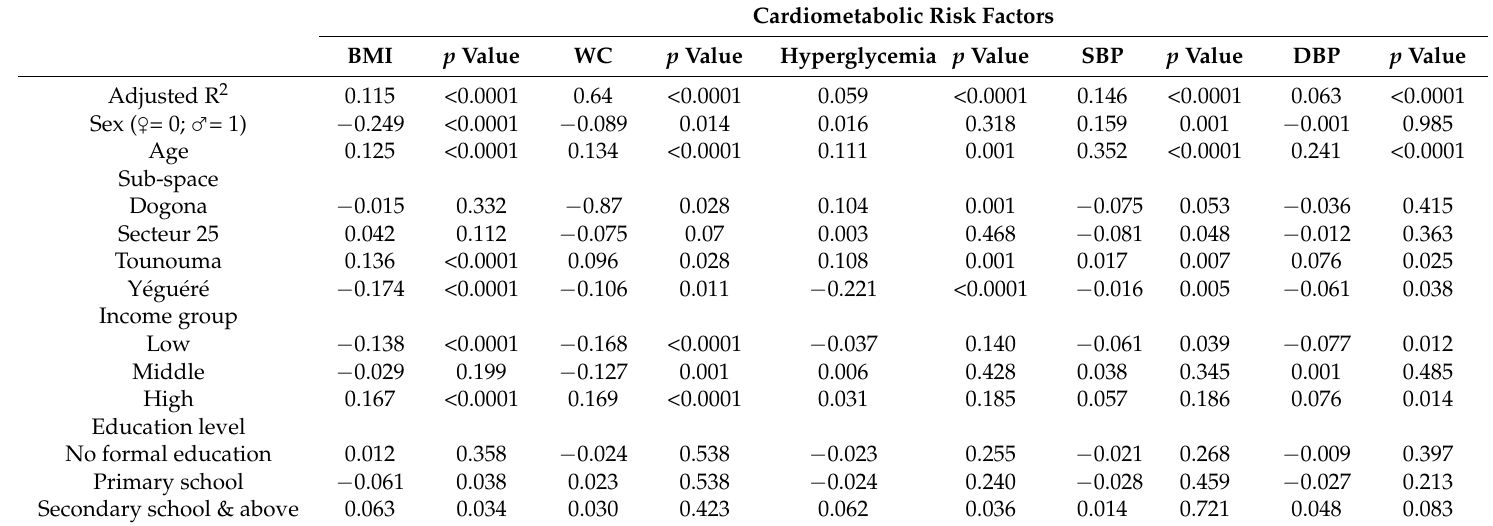
Table 3. Multiple linear regression analysis of the association between cardiometabolic risk factors and location and socio-demographic data. Cardiometabolic Risk